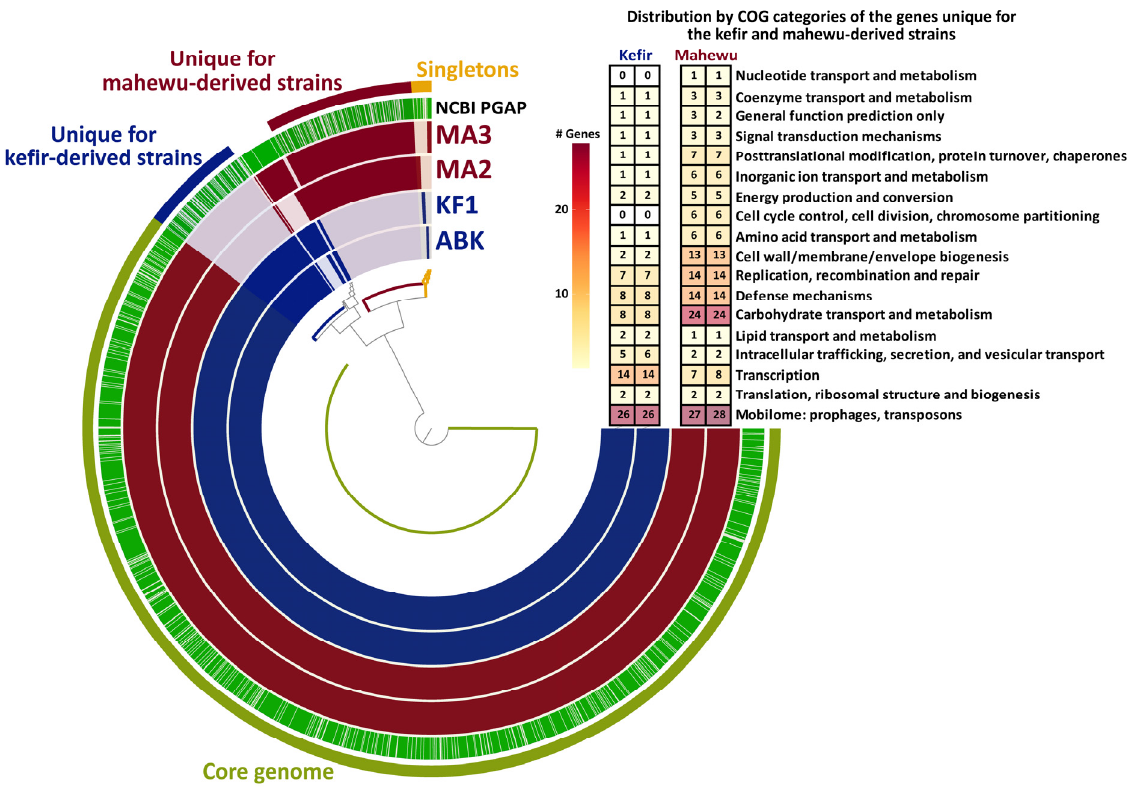
Figure 7. The Anvi’o diagram [45,46] representing the pan-genome analysis of kefir-derived (KF1 and ABK) and mahewu-derived (MA2 and MA3) strains of L. paracasei . Gene clusters (four inner rings) were ordered (inner dendrogram) according to their presence (solid color) or absence (grey color). The fifth ring depicts gene clusters that received functional annotation from the NCBI PGAP annotation pipeline [40], and the sixth ring depicts the binning of the pan-genome into core and accessory genomes. The later was further subdivided into gene clusters unique to either kefir- or mahewu-derived strains and strain-specific clusters (singletons). The heat map depicts the distribution by COG categories of the genes unique to either kefir- or mahewu-derived strains (“niche-specific genes”); niche-specific genes without an assigned COG category or assigned the “Unknown function” category were excluded from the heat map.